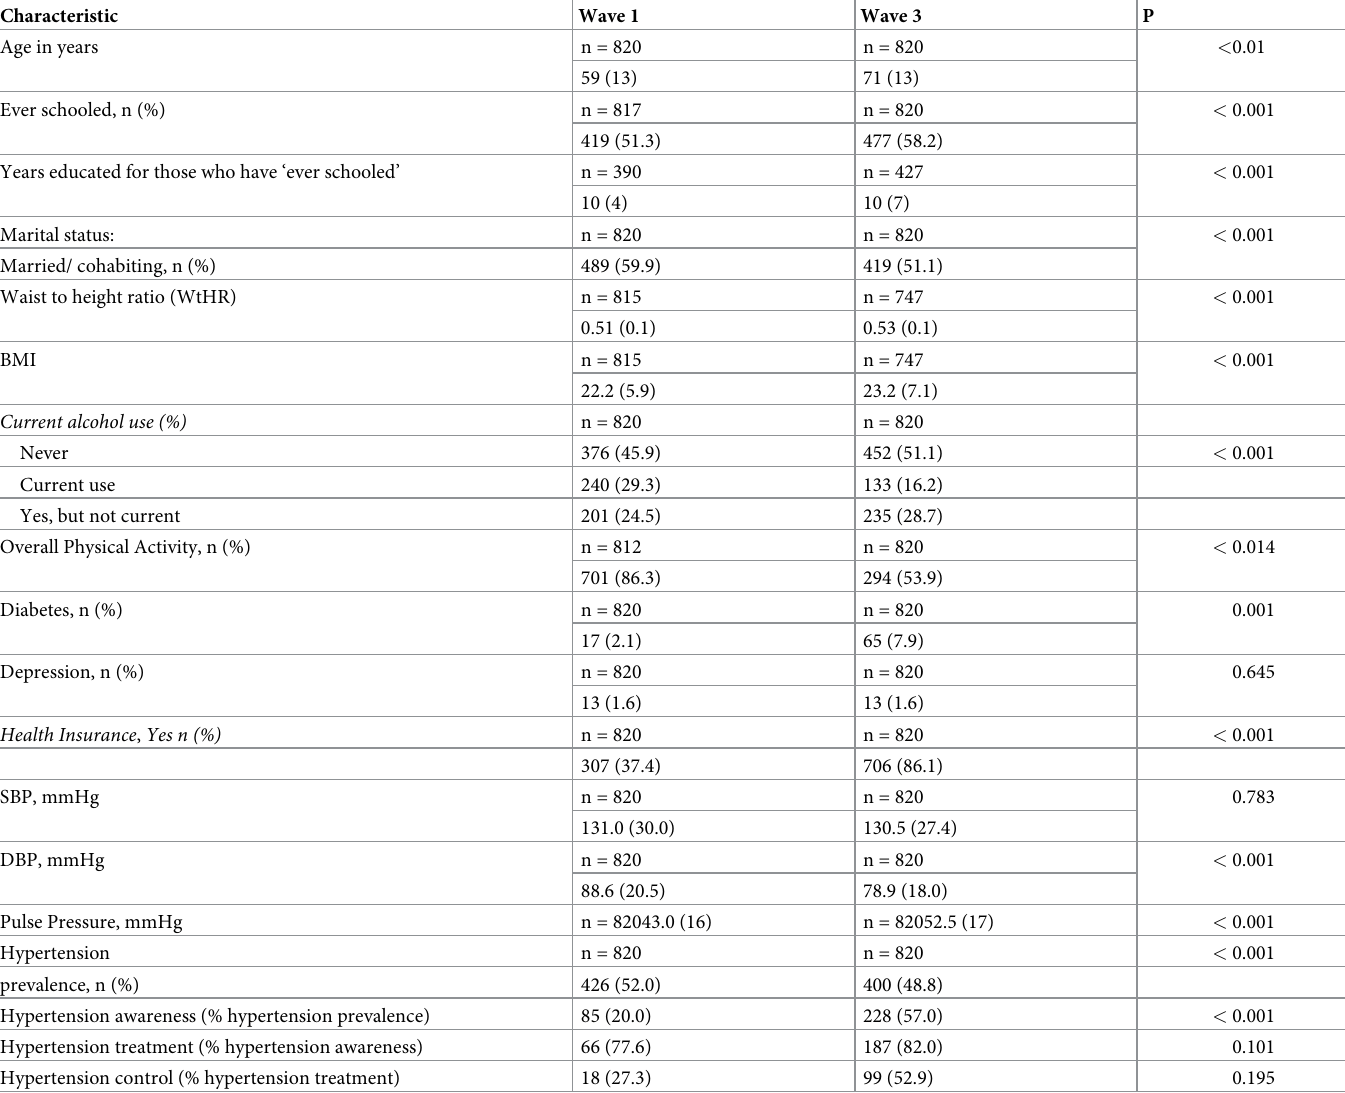
Table 1. Characteristics of participants in WHO-SAGE, Ghana W1 and W3 (n = 820).